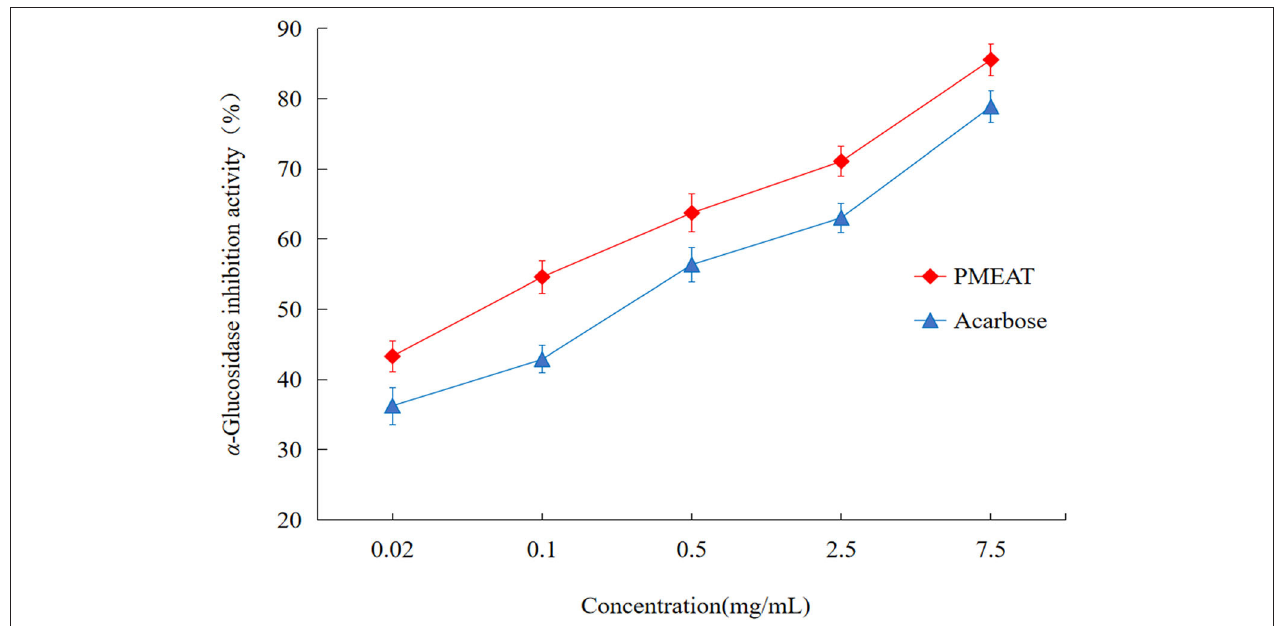
FIGURE 2 | The in vitro α - glucosidase inhibitory activity of PMEAT. The line chart depicting the inhibition rate against α -glucosidase of PMEAT (red color) and acarbose (blue color) at different solution concentrations. Three parallel samples for the two test solutions were used to perform this in vitro